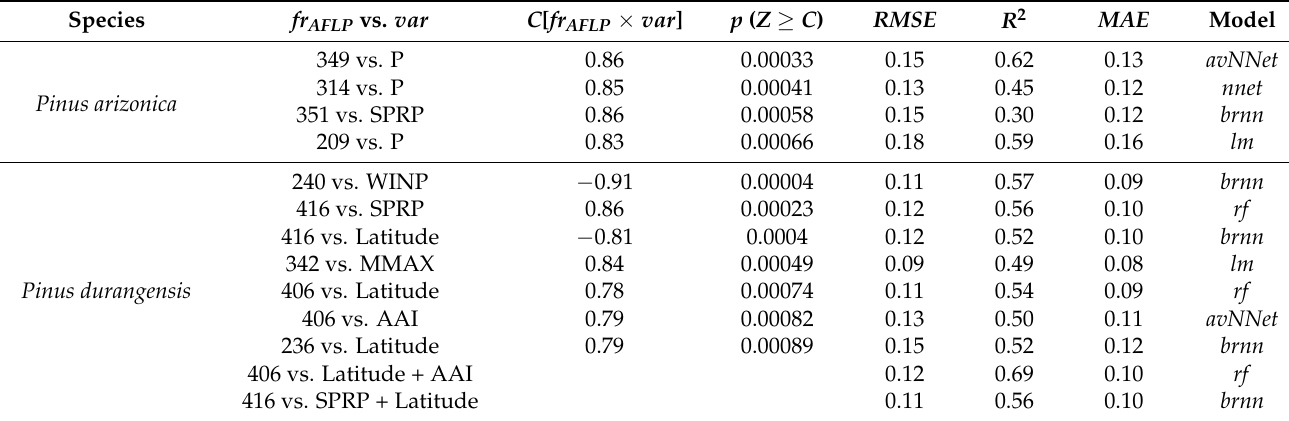
Table 1. Significant covariations ( C [ fr AFLP × var ]) found between relative AFLP variant frequencies ( fr AFLP ) in Pinus arizonica and P. durangensis and various environmental variables ( var ). Outlier loci for each AFLP were detected from different selection models.